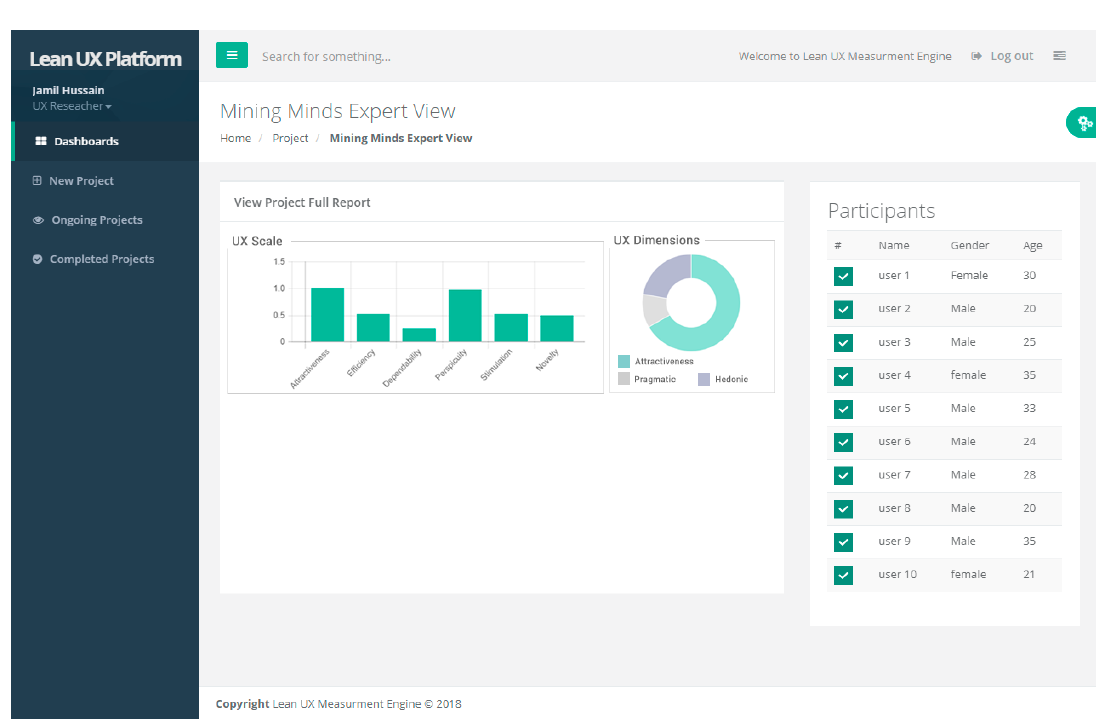
Figure A5. Task wise result view.